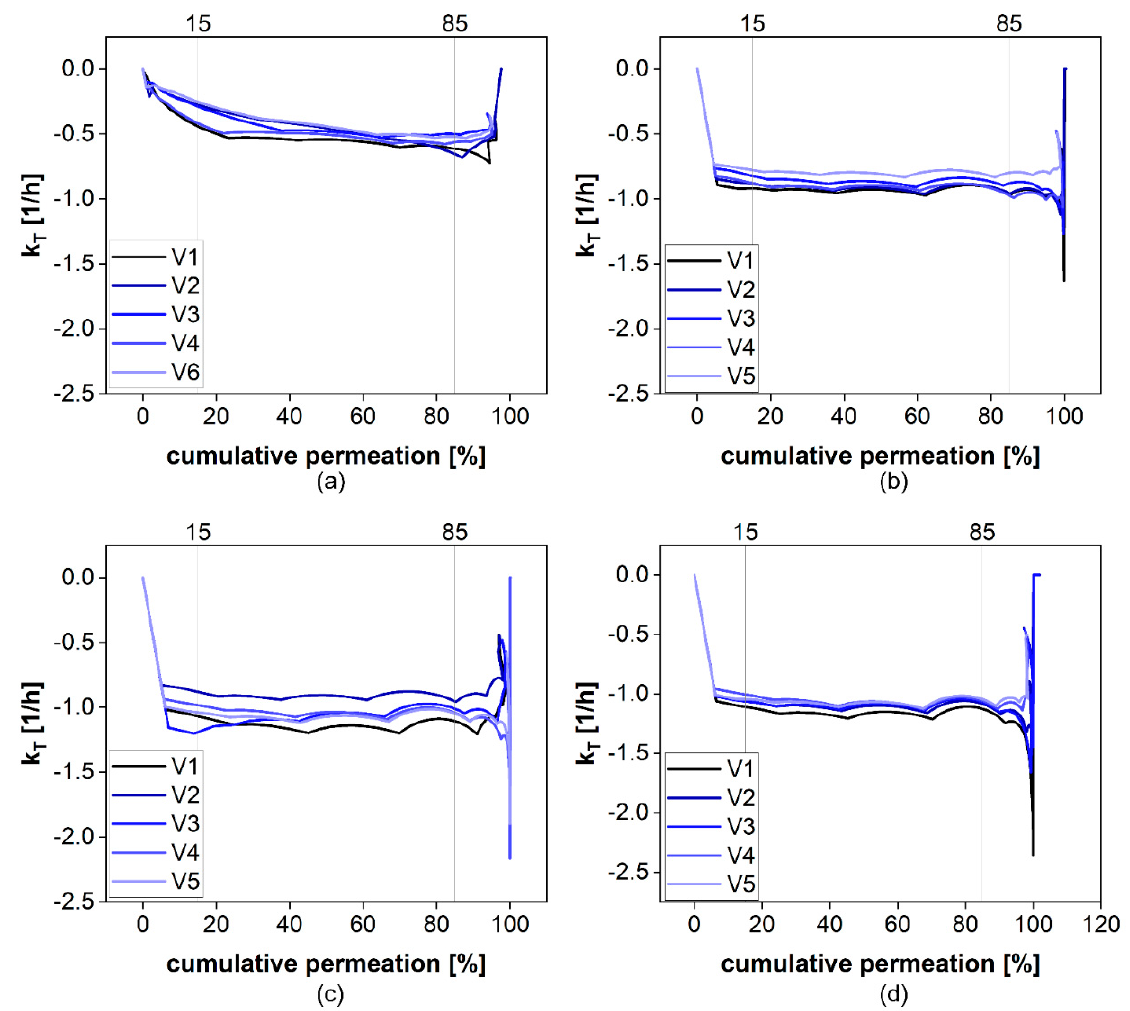
Figure 9. The calculated k T values at 0 ( a ), 25 ( b ), 50 ( c ), and 100 rpm ( d ).